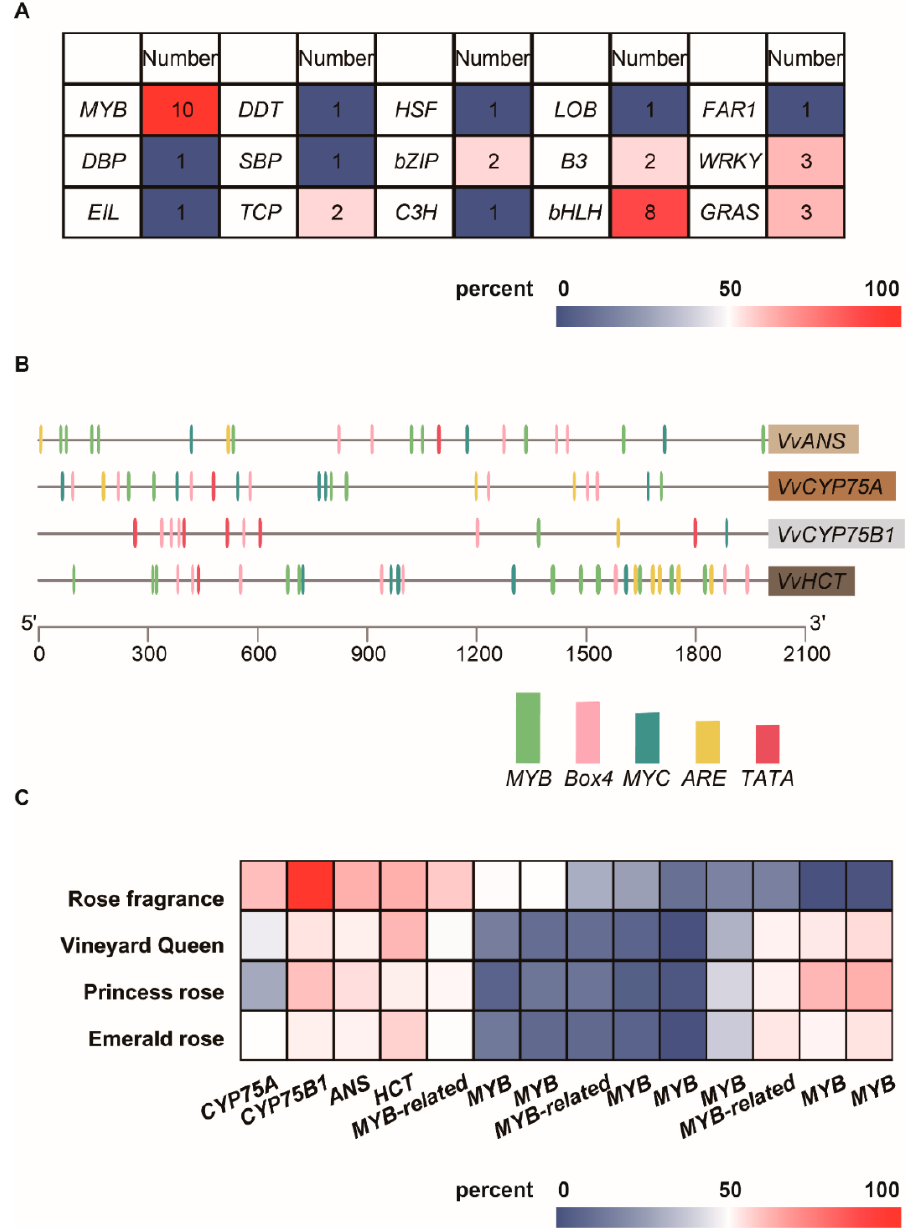
Figure 4. Related transcription factor filtering. ( A ) Individual quantities of differential transcription factors for four grape varieties. ( B ) Binding site of a transcription factor to pre-2000 bp in the enzyme gene promoter. ( C ) Heat map of differentially expressed genes.